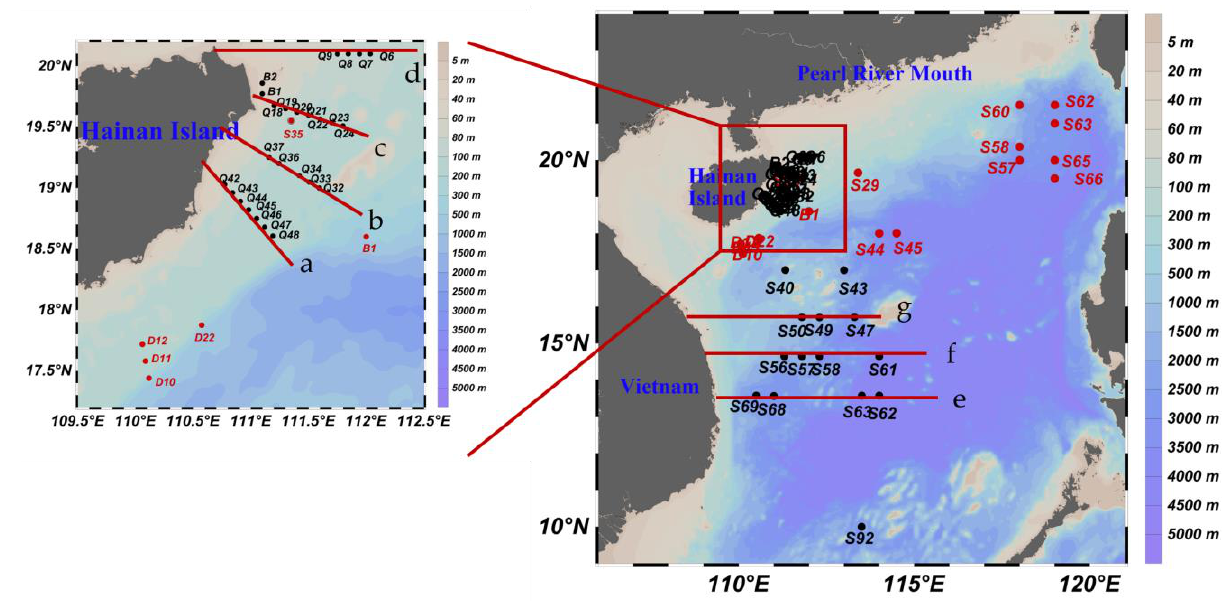
Figure 2. Locations of the stations in the northwestern South China Sea. The black circles denote the stations during the 2013 cruise. The red circles denote the stations during the 2015 cruise. The red lines indicate the seven sections.